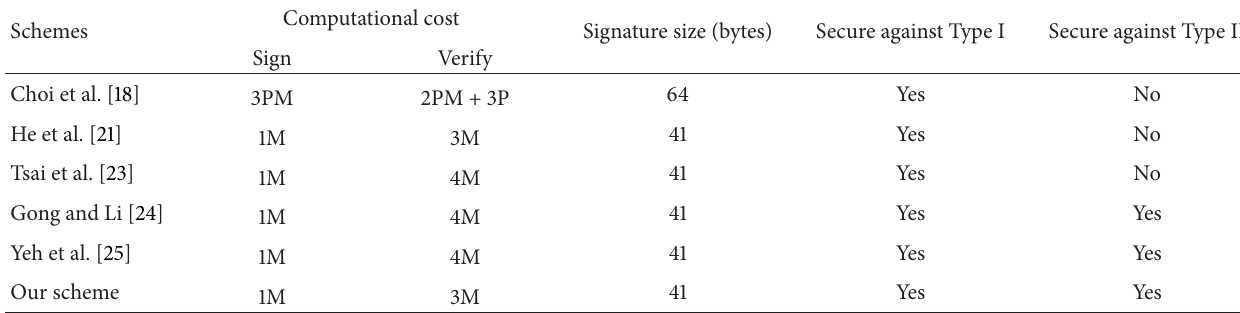
Table 1: Performance